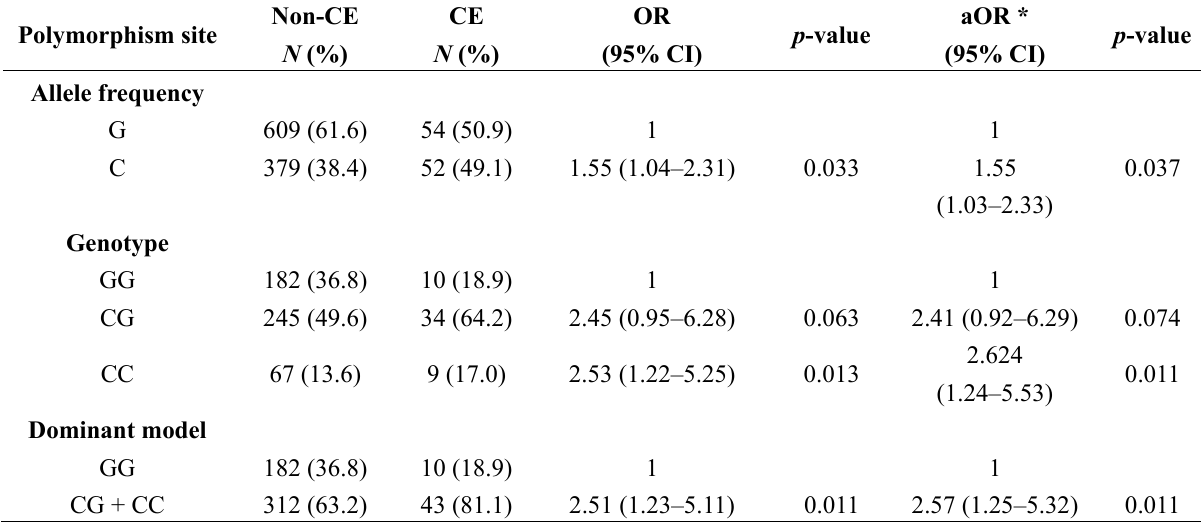
Table 3. hOGG1 Ser326Cys genotype and ectasia status.